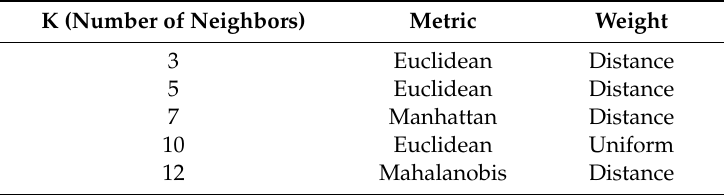
Table 1. K values for K Nearest Neighbors (KNN) model. K (Number of